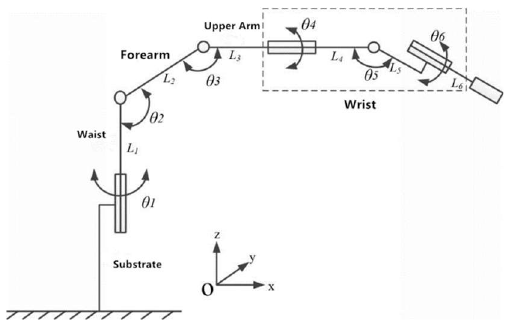
Figure 1. Schematic diagram of